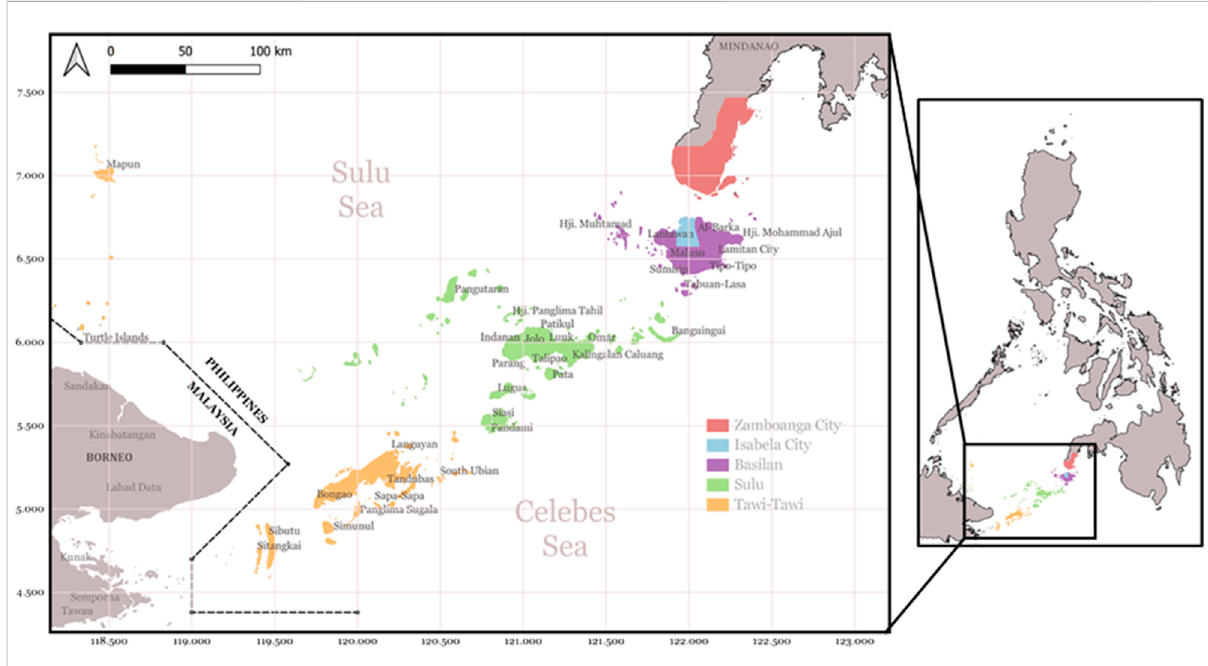
FIGURE 1 The Sulu Archipelago and Zamboanga City, Philippines. The map was created using QGIS version 3.22.2. A free and open-source Geographic Information System project by Open-Source Geospatial Foundation (OSGeo).